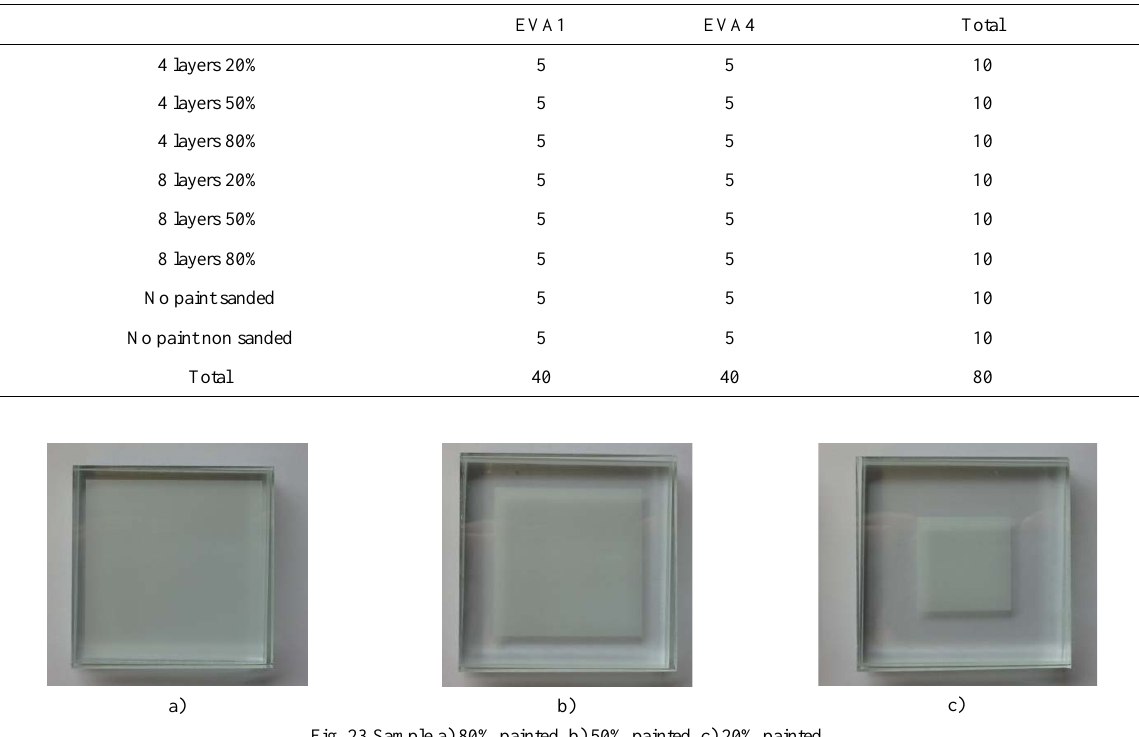
Table 9: Matrix for the desired samples of shear tests EVA1 EVA4